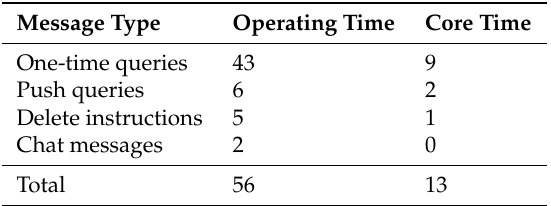
Table 4. Number of uplinked messages.